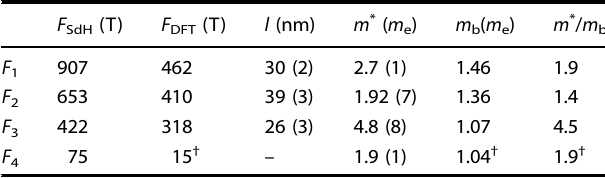
Table 1. Fermi surface parameters found by experiment and DFT calculations (LT